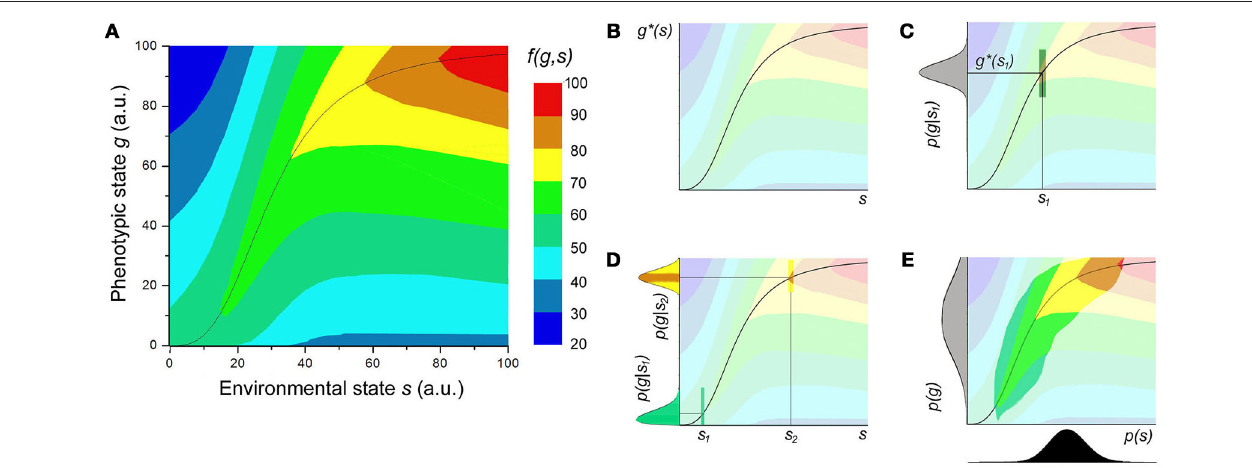
FIGURE 3 | Graphical representation of the definitions. (A) Height map of a possible fitness function f (g,s) (as percentage of the maximum) of one dimensional environmental state and phenotypic state in arbitrary units. Inspired by Taylor et al.’s analysis [76] of Dekel and Alon’s data [77]. (B) The function g * ( s ) is given by the phenotypic state with the highest fitness for each environmental state. (C) Because of intracellular stochasticity, even a fixed known environment can result in a distribution of phenotypes, given by p (g|s) (gray). The mean would not need to lie exactly on g * ( s ) because f (g,s) can drop off asymmetrically, and evolution would optimize <f (g,s)> (colored rectangle). (D) The shape of the distribution of phenotypes can change for different reasons: The noise in the distribution tends to increase with increasing mean for statistical reasons, but the pressure to reduce the width can vary (in this case, increase) with the curvature of f (g,s). This is represented by the colors indicating the fitness within the distribution. (E) If the environment also has a distribution, p (s) (black), the convolution of all p (g|s) with p (s) gives the total distribution of phenotypes, p (g). Note that this doesn’t mean that p (g,s) is just the multiplication of probabilities, but it’s shape will be determined in part by f (g,s). In f ( g , s ) this case corresponds to the height in the colored region, integrated with weight p (g,s). h i